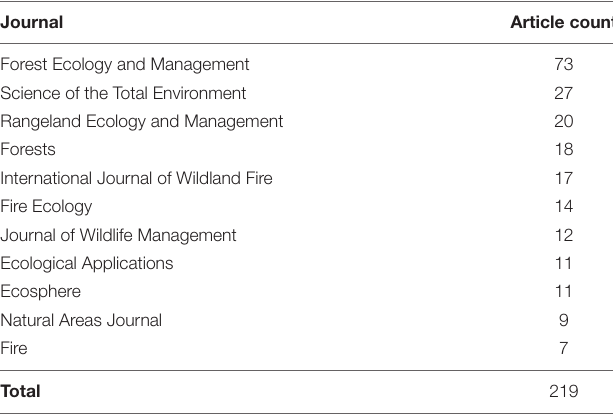
TABLE 1 | The number of published studies from 2016 through 2020 that report on an ecological prescribed fire experiment for the 11 journals